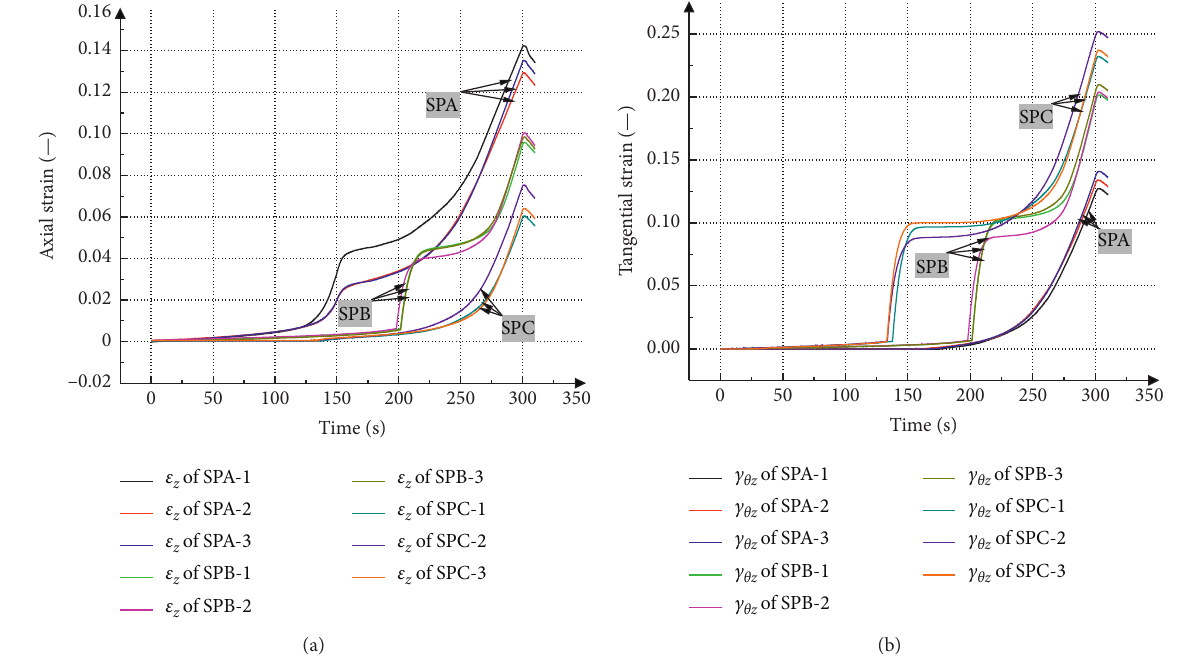
Figure 17: ε c -time (b) curves of stress paths A, B, and C. z -time (a) and θ z